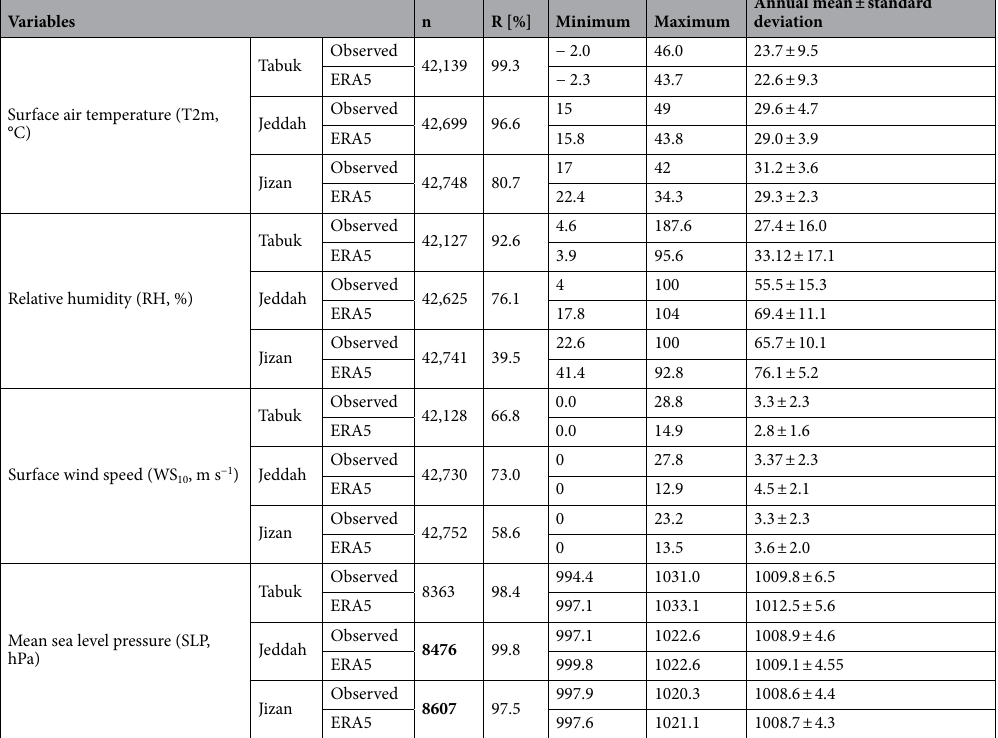
Table 2. Comparison analysis between the observed and ERA5-based weather variables in Tabuk, Jeddah and Jizan: n = number of observations, and R = correlation